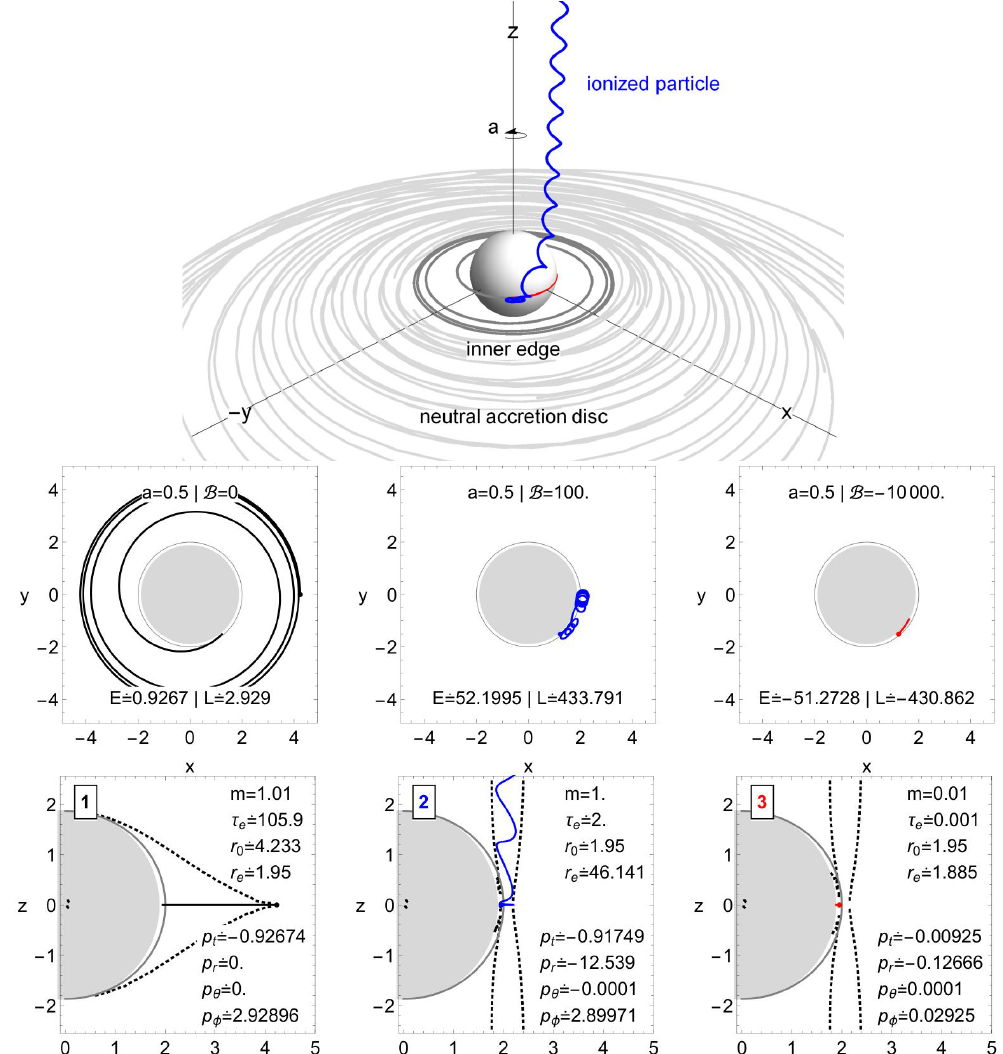
Figure 12. Particle acceleration in vicinity of a magnetized rotating black hole – 1st neutral particle (black, neutron) has been located on accretion disk inner edge, and starts to fall into the black hole, decaying into two charged particles, 2nd (blue, proton), and 3rd (red, electron). While the 3rd particle (red) falls into the black hole with large negative energy, the 2nd (blue) gets large energy and due to the so called chaotic scattering escapes along the magnetic field